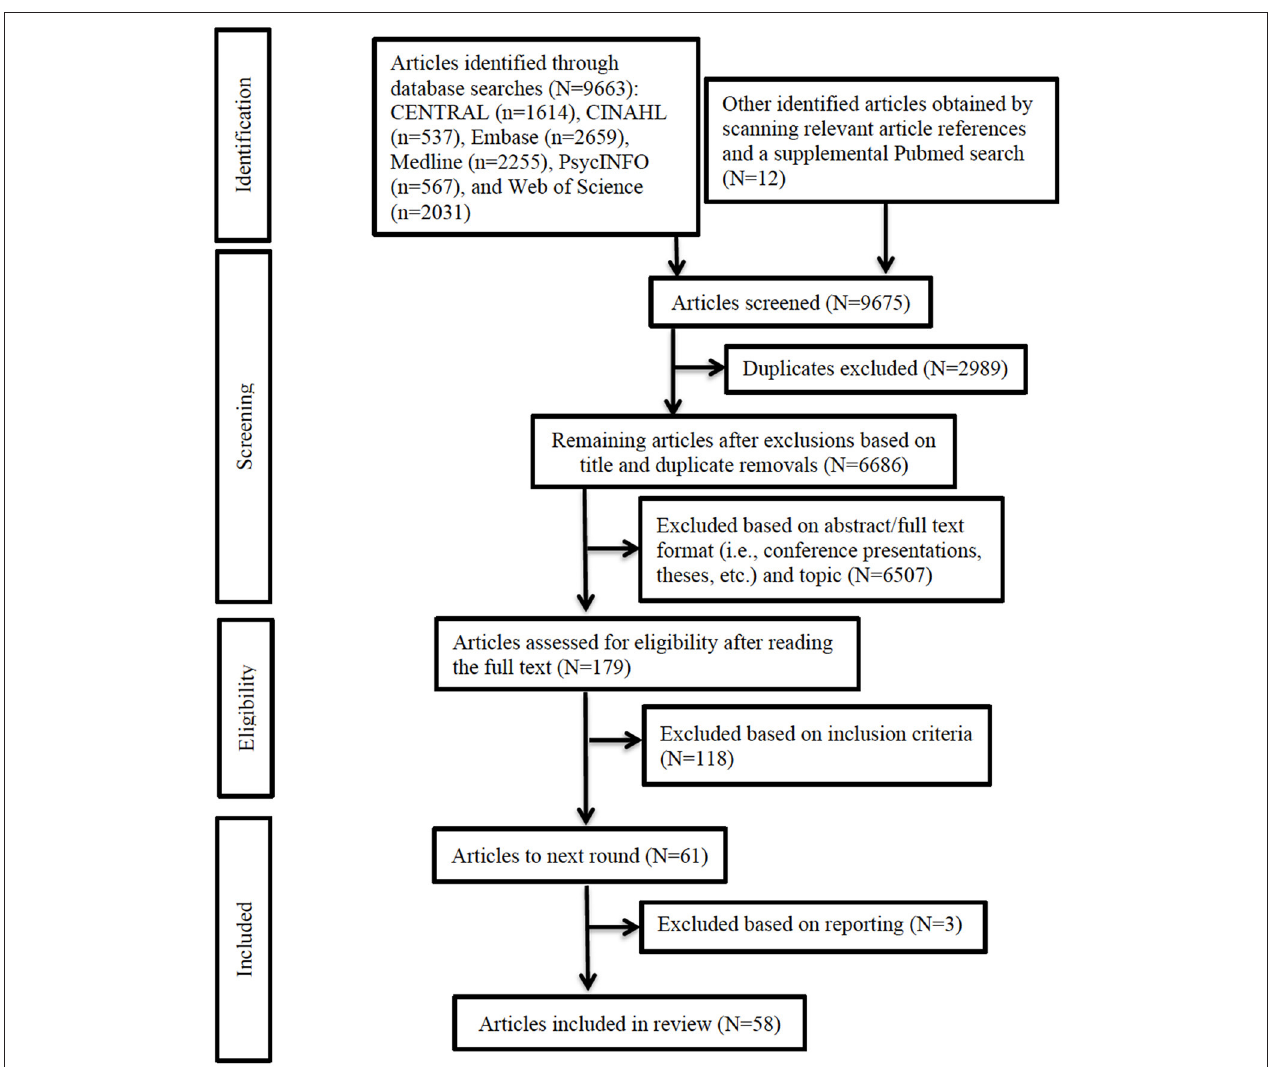
FIGURE 1 | PRISMA flow diagram. Flowchart depicting study selection process and outcome. PRISMA, Preferred Reporting Items for Systematic Reviews and